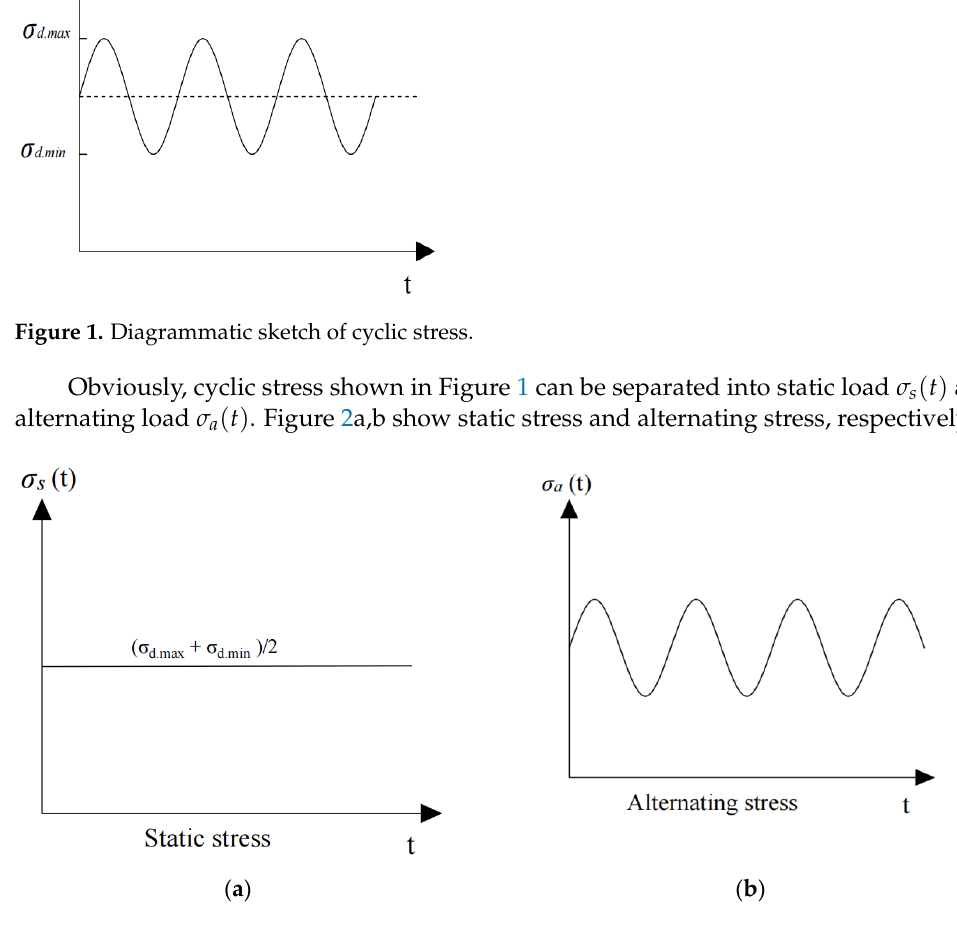
Figure 2. ( a ) Diagrammatic sketch of static stress; ( b ) Diagrammatic sketch of alternating stress. The static stress 𝜎 (cid:3046) (𝑡) and the alternating stress 𝜎 (cid:3028) (𝑡) in accordance with the above analysis can be expressed as